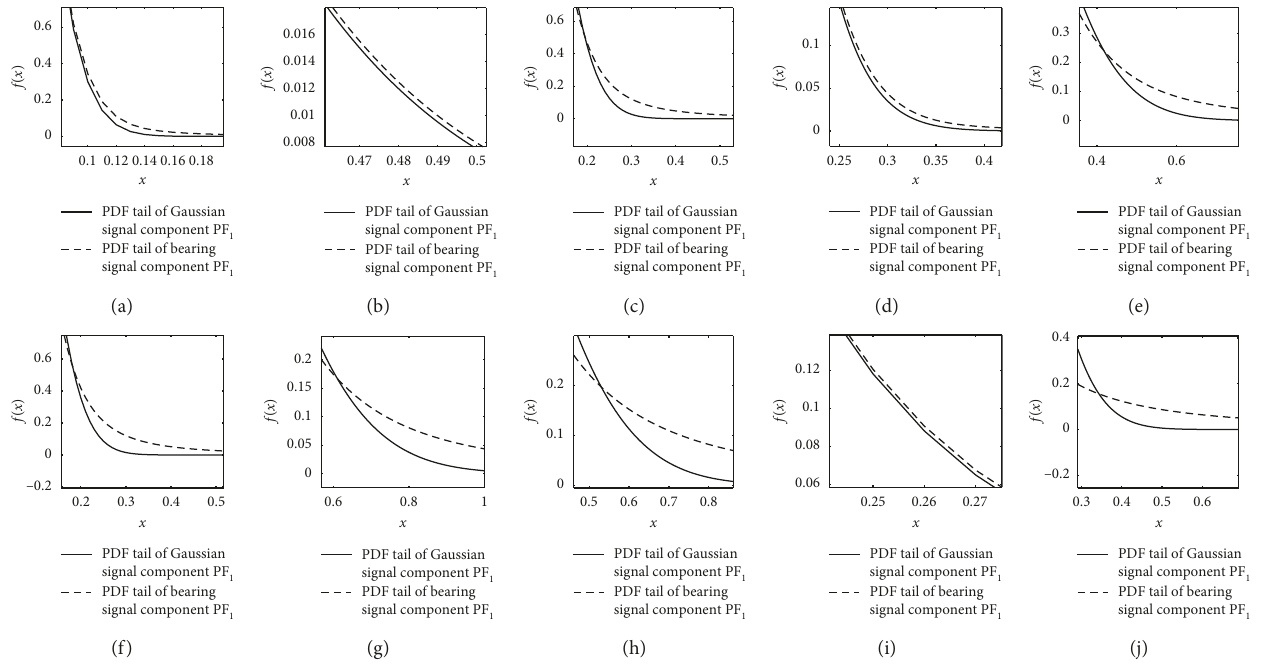
Figure 3: PDF curve comparison of different signal components PF